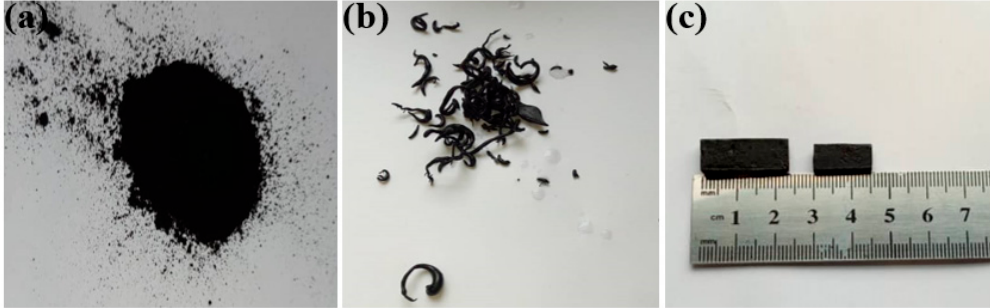
Figure 1. Digital image of ( a ) C-Fe 3 O 4 ( b ) C-Fe 3 O 4 /PVDF (M40) ( c ) rectangular shaped